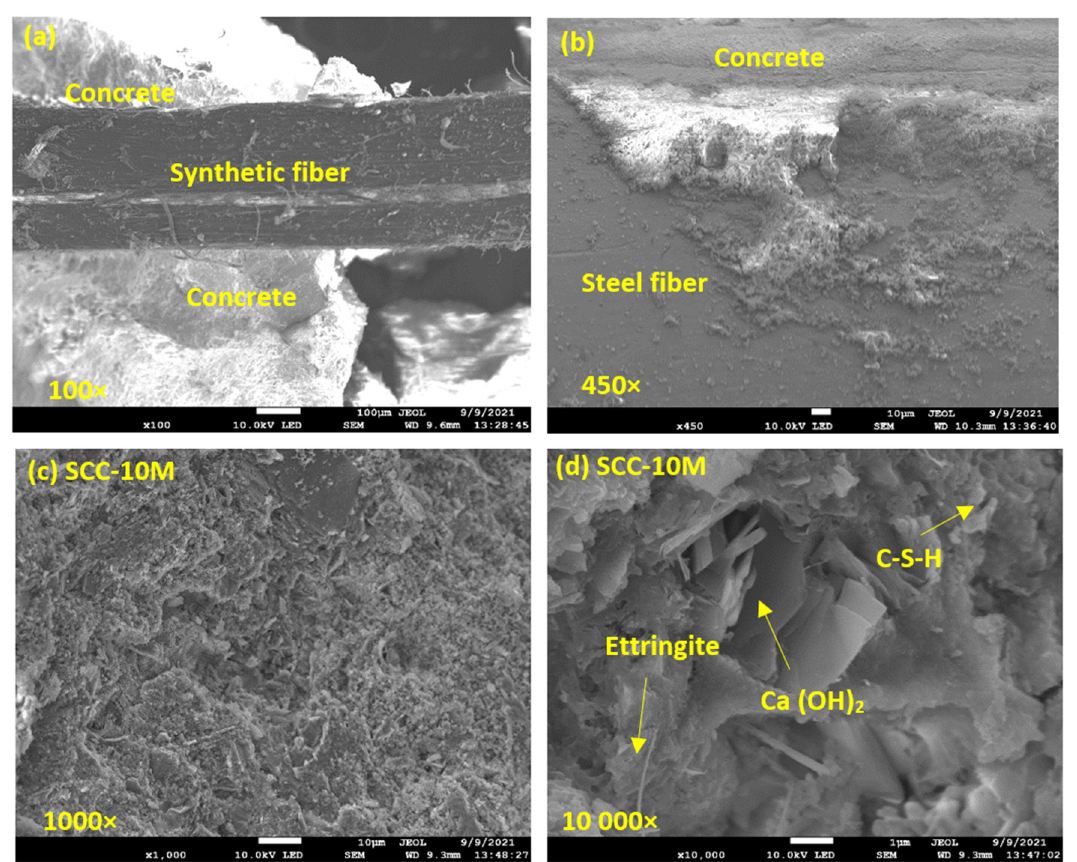
Figure 8. The SEM microstructure ( a ) bonding between fractured SCC samples fixed with synthetic fibers, ( b ) bonding between fractured SCC samples fixed with steel fibers, ( c ) SCC-10M sample at 1000×, and ( d ) SCC-10M sample at 10,000× magnification with corresponding hydration crystalliza- tion products.